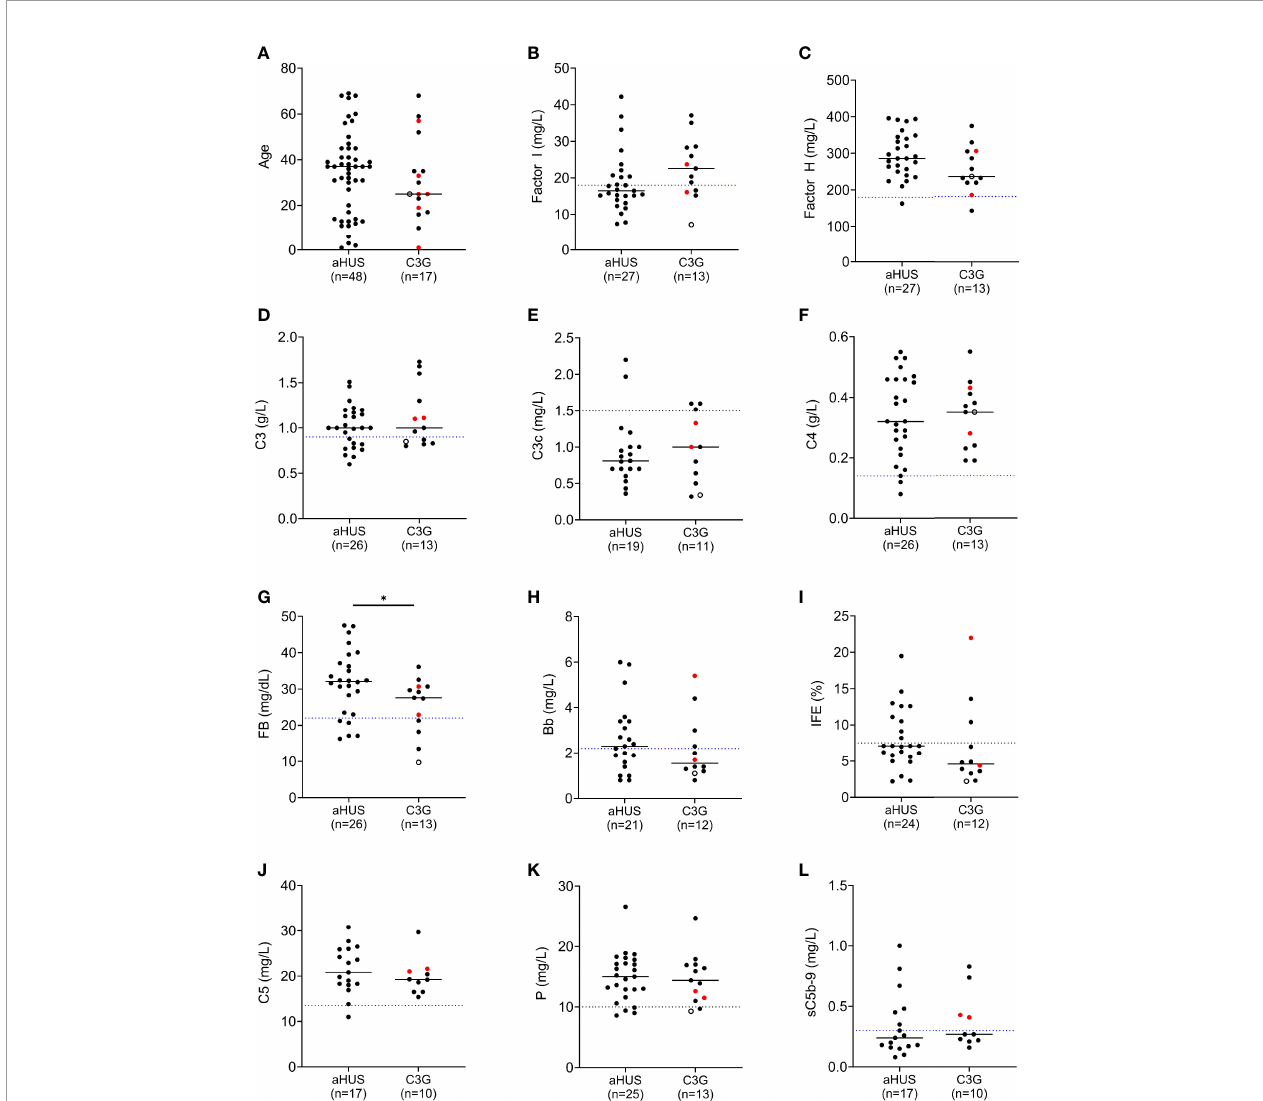
FIGURE 2 | Complement biomarker pro fi ling in aHUS and C3G patients. (A) Age distribution. (B) Factor I levels. (C) Factor H levels. (D – H) Biomarkers for alternative pathway (AP) activity including C3 and factor B, and associated activation products C3c and Bb. (I) AP fl uid-phase activity by immuno fi xation eletrophoresis. (J – L) Biomarkers for terminal pathway activity including C5, properdin and soluble terminal complement complex (sC5b-9). (left column, aHUS; right column-red dots, DDD patients; black dots, C3GN patients; open circle, C3GN/aHUS patient; dashed line, lower limit of normal value for each assay; patients on eculizumab excluded from (J, L) ; * P <